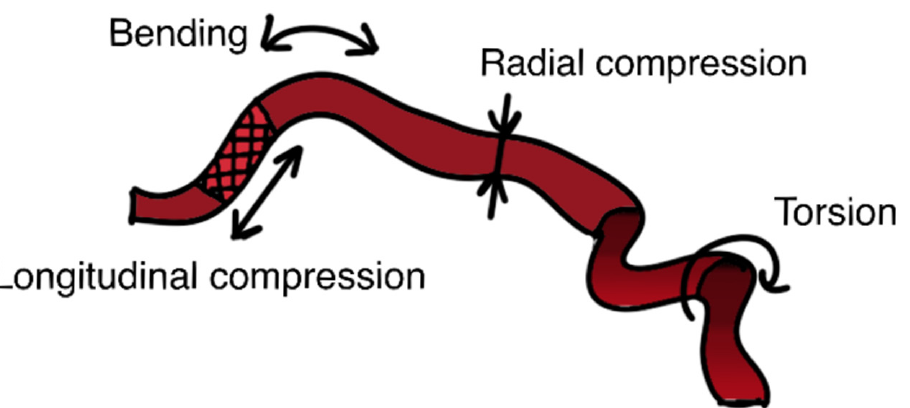
Figure 1. Challenges with mechanical properties of stents: longitudinal compression, bending, radial compression and torsion.